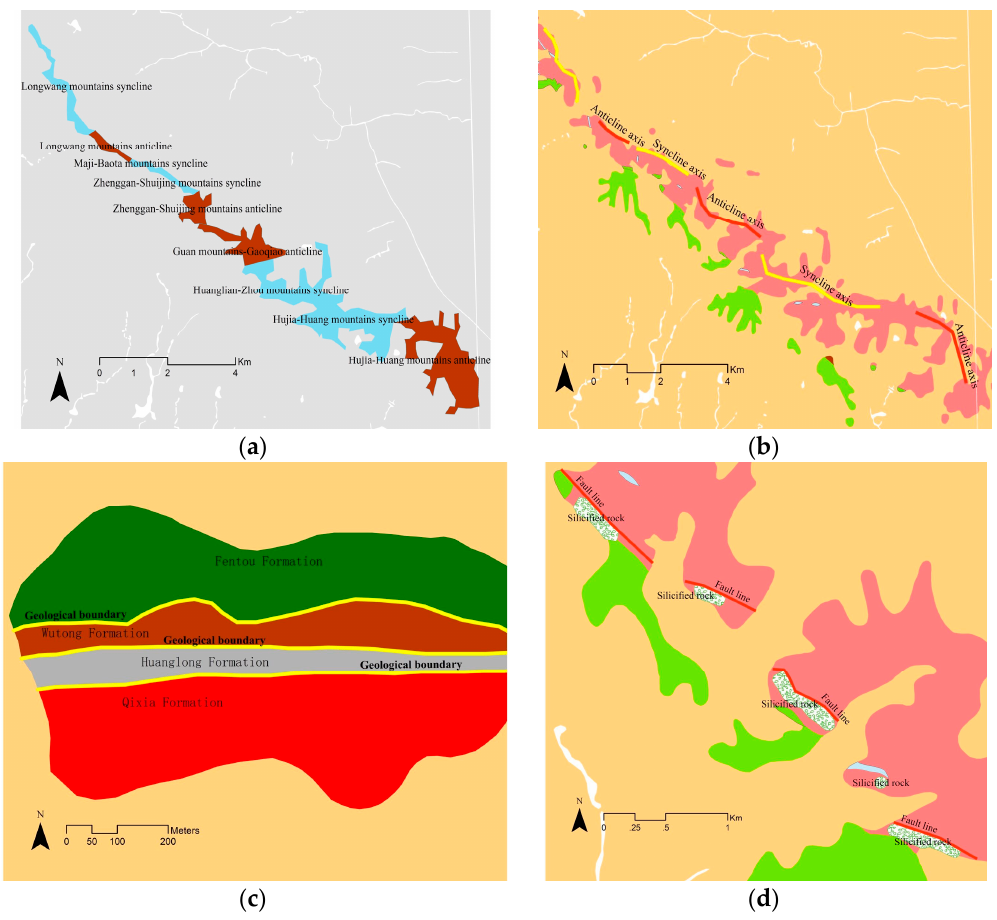
Figure 14. Geological relationships among regional geological structures. ( a ) Jizhuang-Houzhuxiang anticlinorium; ( b ) Jizhuang-Houzhuxiang folding axis line; ( c ) conformable contact relationship; ( d ) faulted contact relationship.